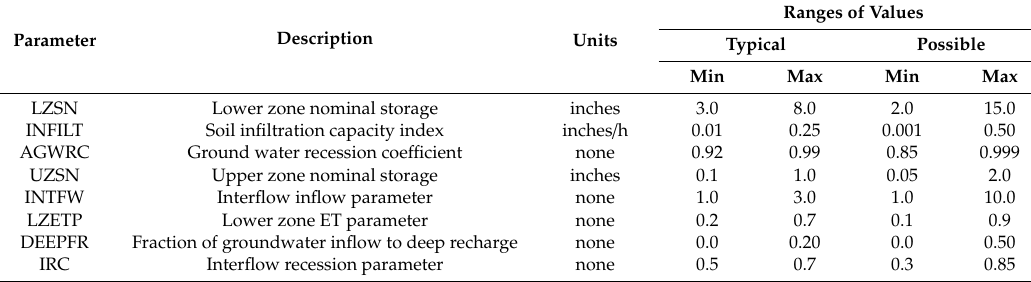
Table 3. Parameters related to flow of the HSPF model. This table was derived from the United States Environmental Protection Agency